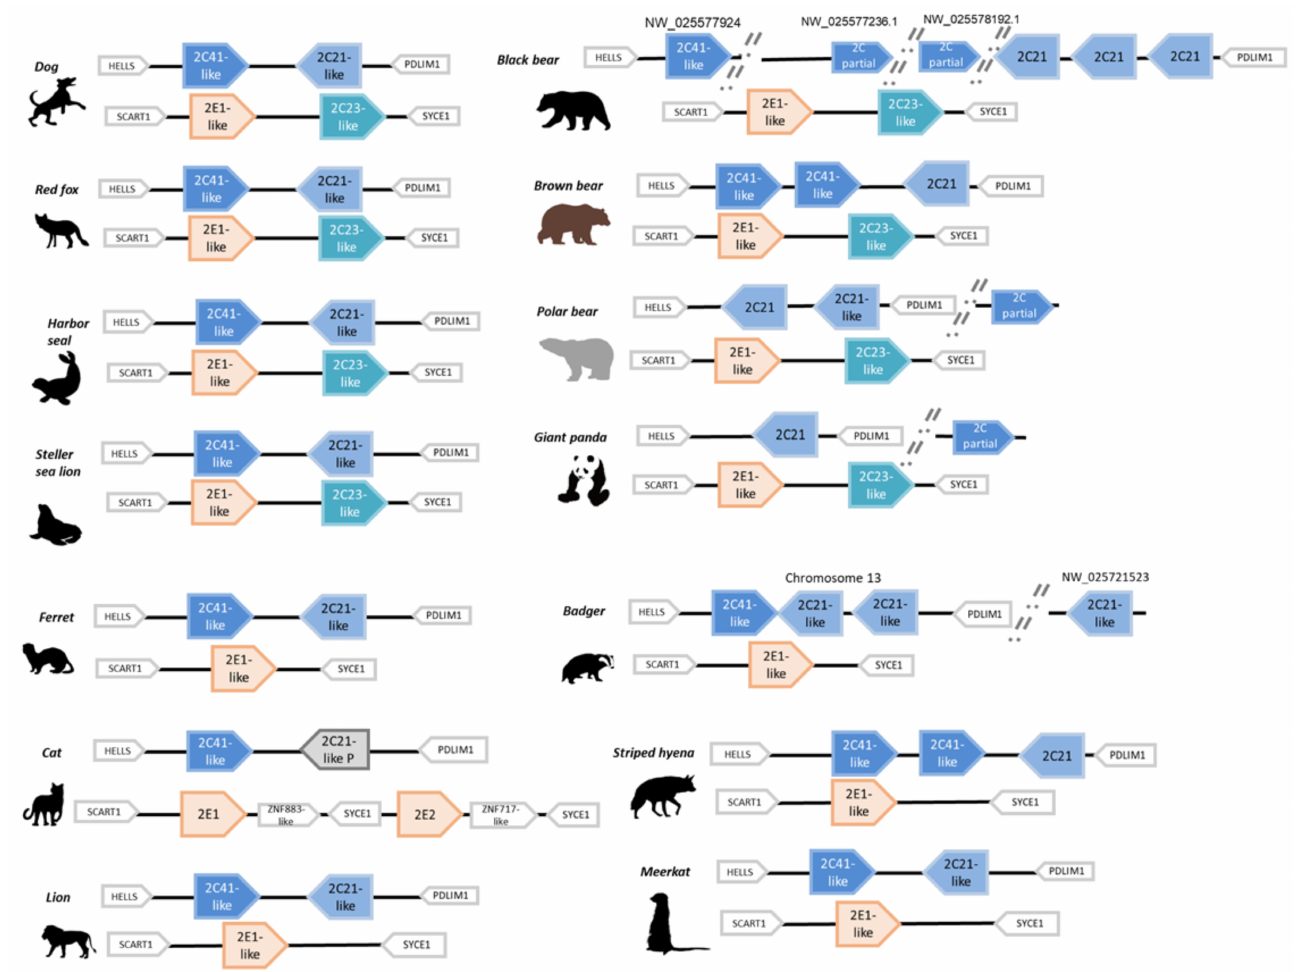
Figure 2. Synteny of CYP2Cs and CYP2CEs clusters in Carnivora. Synteny of the CYP2C cluster and the CYP2CE cluster among Carnivora are shown. Representative species for each family were selected. Phylogenetic-analysis-supported classifications were applied for each isoform and colored based on each clade. CYP2C41s are shown in blue, CYP2C21s in pale blue, CYP2C23s in brilliant blue, and CYP2Es in pale orange. Letters on each locus show coding contigs if separately coded. Pseudogenes are shown as black or gray